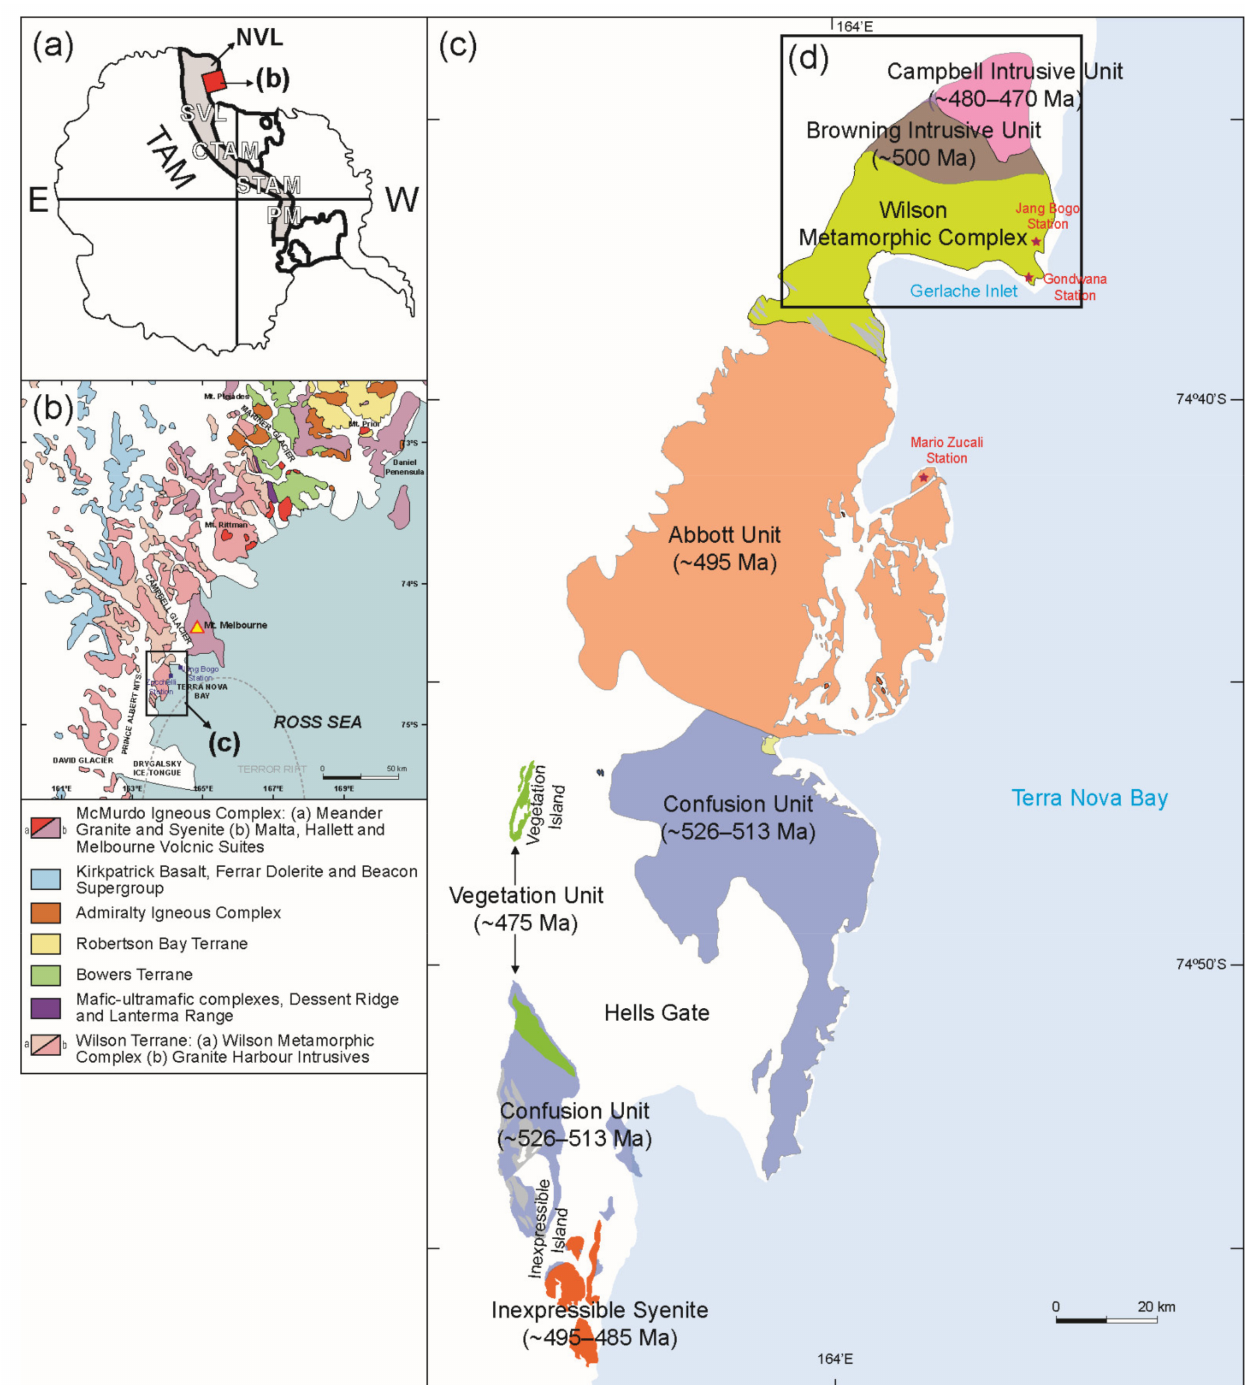
Figure 2. Maps (modified from [13,28]) showing ( a ) the location of northern Victoria Land (NVL) in Antarctica, ( b ) geologic of NVL including the distribution of rocks in the Granite Harbour Intrusives (GHI), ( c ) simplified geology of the Terra Nova Intrusive Complex (TNIC) and the Wilson Metamorphic Complex (WMC), and ( d ) the study area. A map with details for ( d ) is provided in Figure 1. TAM: Transantarctic Mountains; SVL: southern VL; CTAM: central TAM; STAM: southern TAM; PM: Pensacola